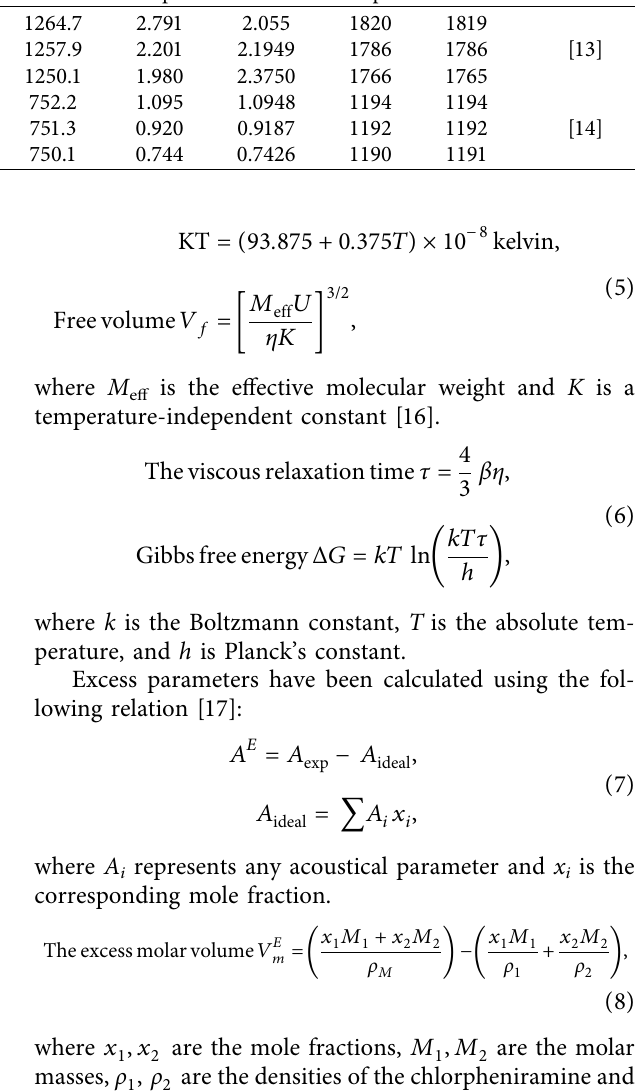
Table 1: Comparison of density, viscosity, and ultrasonic velocity of pure chlorpheniramine and 1-propanol at 303K, 308K, and 313 K in the atmospheric pressure. S.